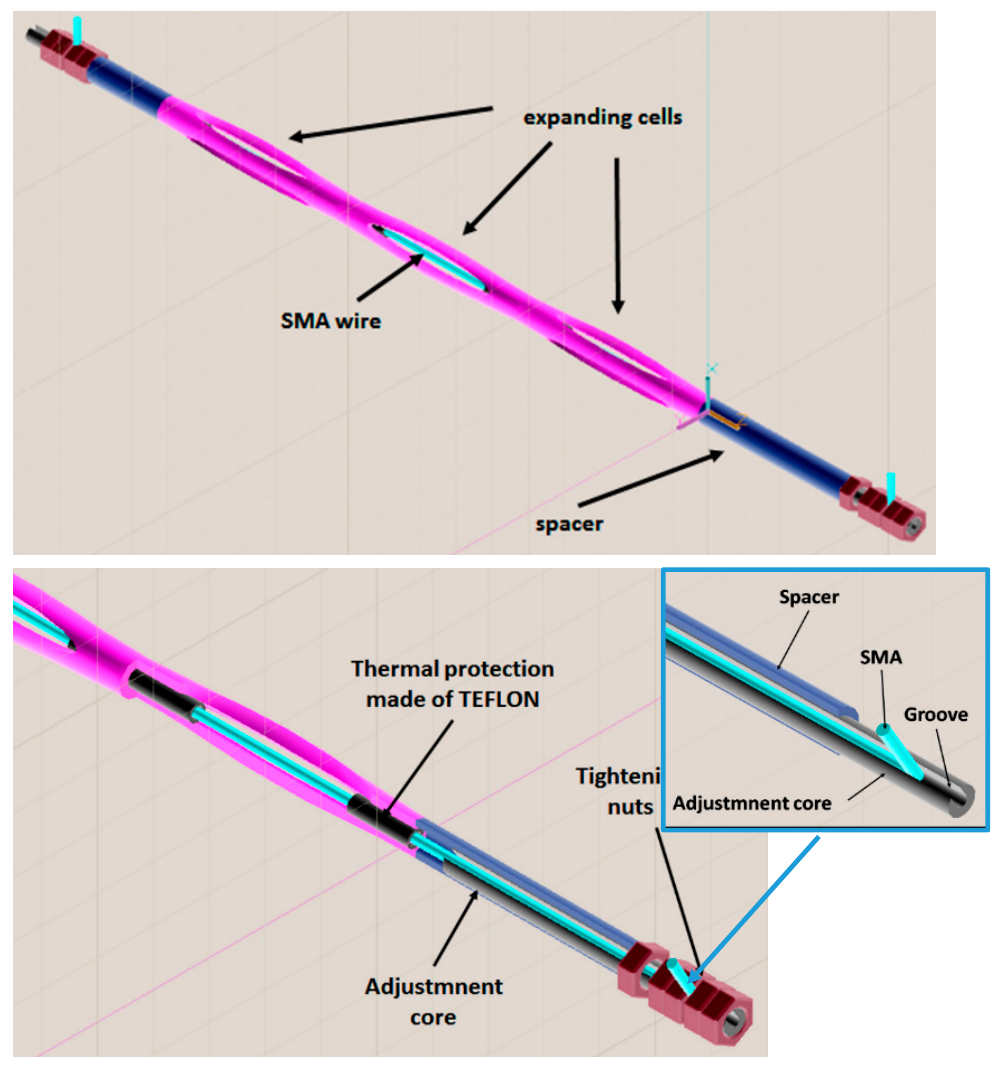
Figure 16. Digital mockup of a 3-cell cluster, integrated with an SMA wire: global view ( top ); detail of the terminal ( bottom ) with a further magnification on the connection segment ( bottom, top right ).